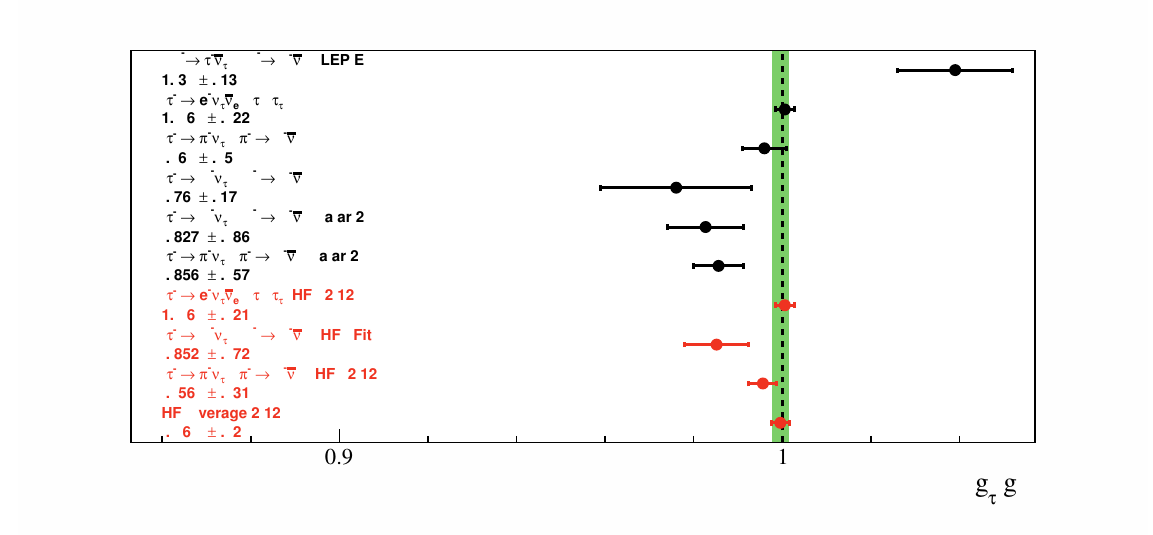
Figure 5. The current status of g τ /g μ lepton universality measurements. The B A B AR measurements are from [5], while the HFAG values are from[1]. The HFAG average [1] is the weighted average of previous τ results with the recent B A B AR g μ /g e measurement. The τ measurements from before B A B AR are from [69]. The other measurements are taken from [1,